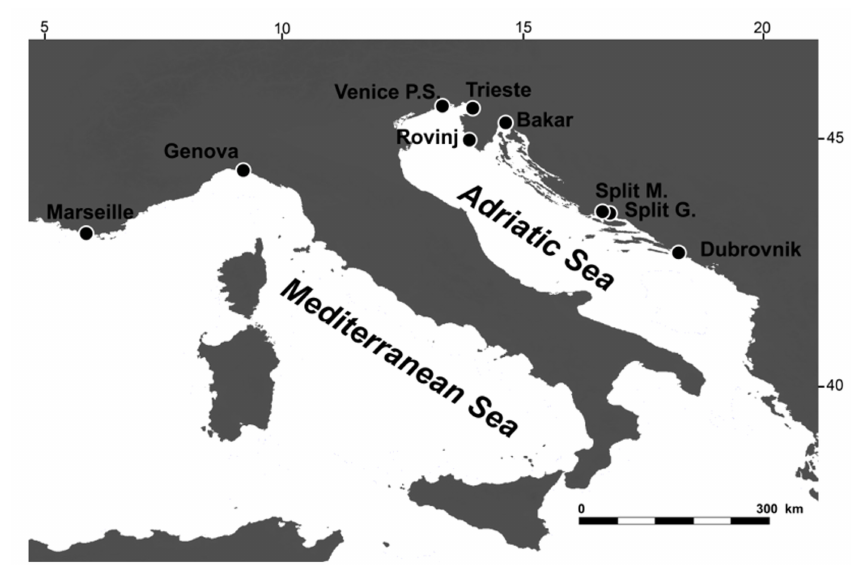
Figure 1. Location of the nine analyzed tidal stations: Marseille (5.35 ◦ –43.32 ◦ , 1885–2012),